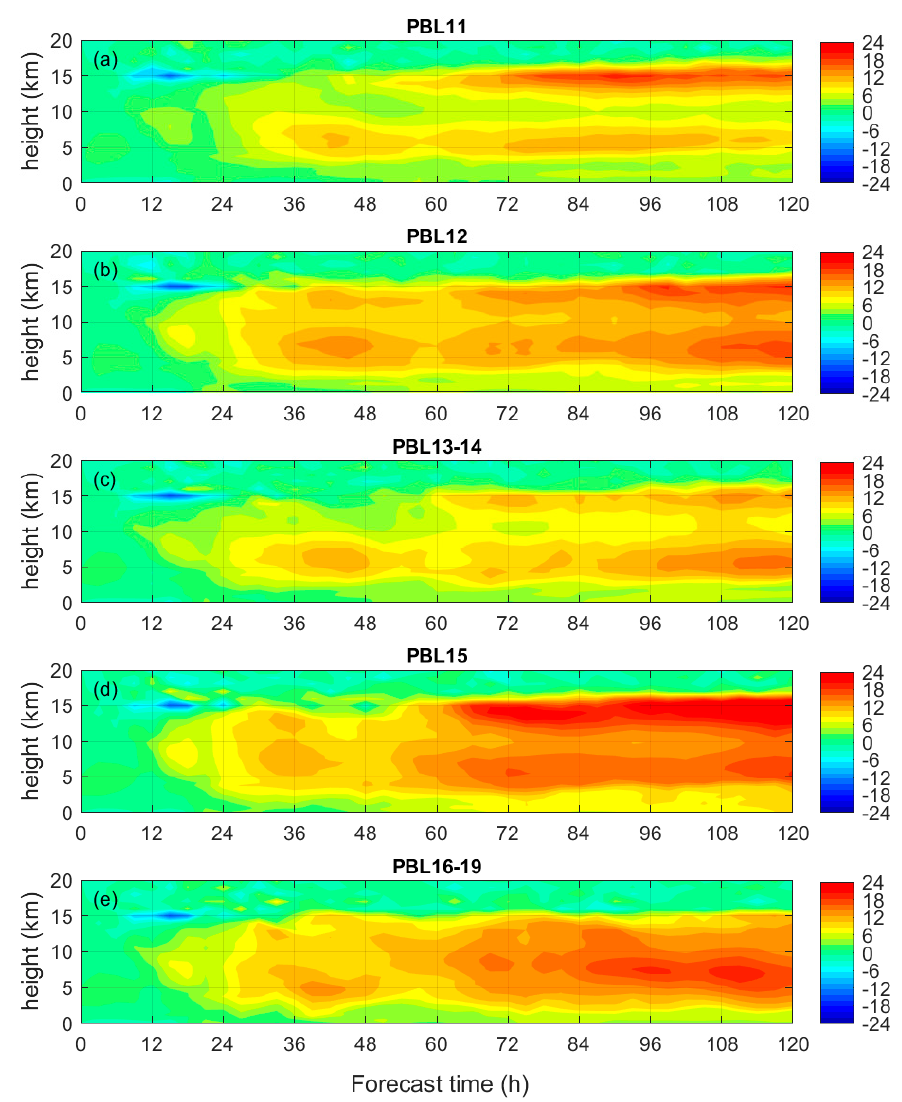
Figure 11. Hovmöller diagram of the warm core anomaly (in K) in the idealized HWRF simulations with ( a ) PBL11, ( b ) PBL12, ( c ) PBL13 ‐ 14, ( d ) PBL15, and ( e ) PBL16 ‐ 19 schemes.